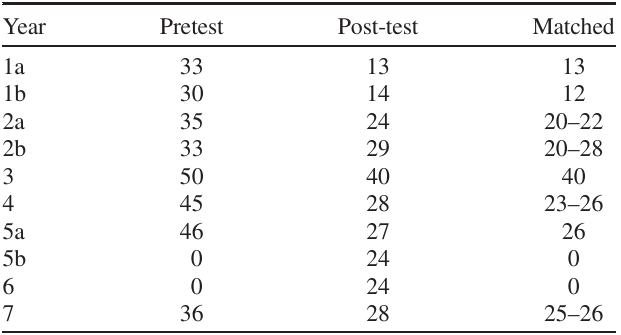
TABLE IV. Number of students in each data set at school 2. Some students in years 2a, 2b, 4, and 7 did not complete all sections of the FMCE, so the number of matched data points is lower for some clusters.